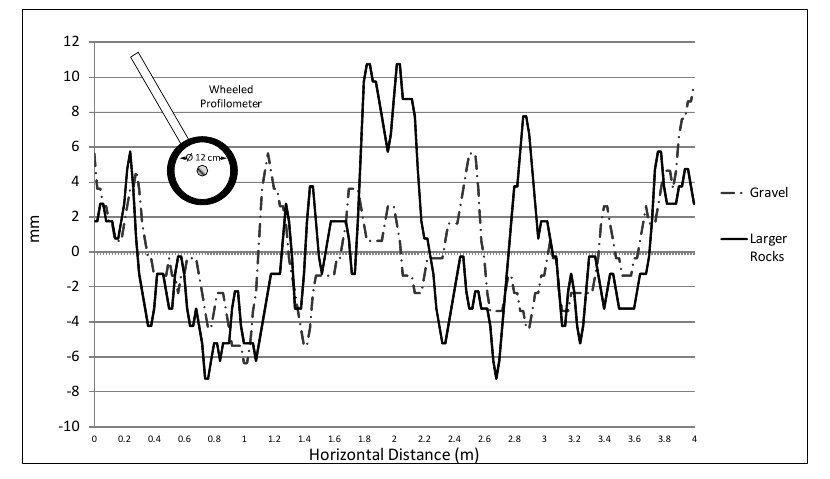
Figure 2. Surface irregularity measured using a profilometer with a reflective marker at the axis along a 4 meters section of the walkway where surface data were